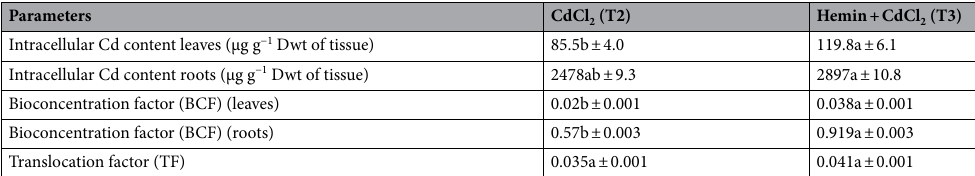
Table 2. Intracellular Cd content, Biological concentration Factor (BCF) and Translocation Factor (TF) in seedlings of V. radiata exposed to different treatments for a period of 96 h.